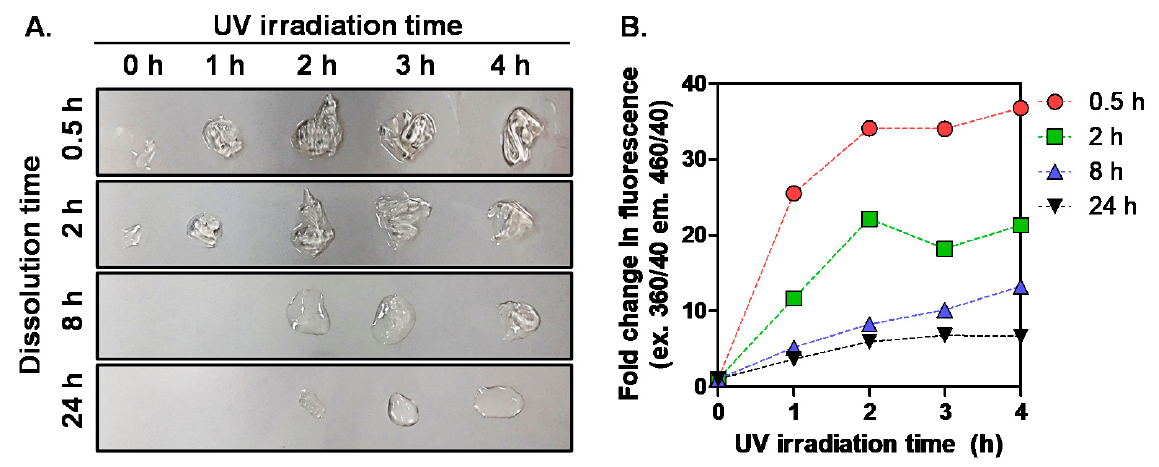
Figure 4. Morphologies of the remaining four SF films ( A ) and fluorescence intensity of the released SF molecules from SF films ( B ) after immersion of films in 6 M urea solution for 24 h (ex. 360/40; em. 460/40) (n = 3; mean ± SD; 1-fold: 0 h UV irradiation).